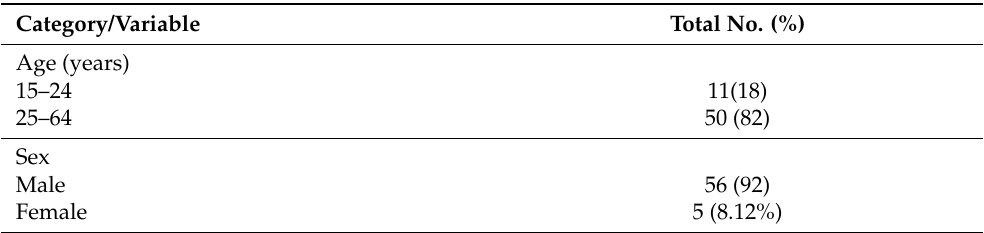
Table 1. Characteristics of study